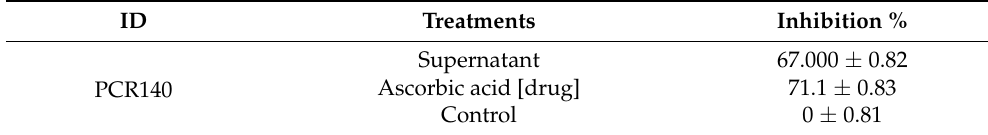
Table 3. In vitro antioxidant of the PCR140.